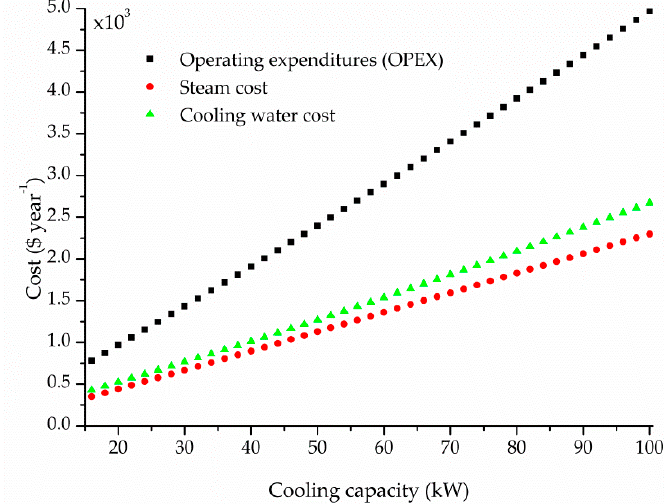
Figure 5. Optimal distribution of the operating expenditures (OPEX) versus the cooling capacity level.